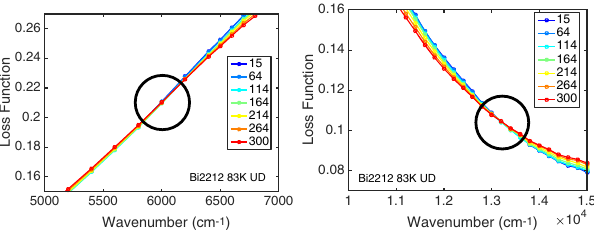
FIG. 19. Isosbestics points for Bi2212 83K